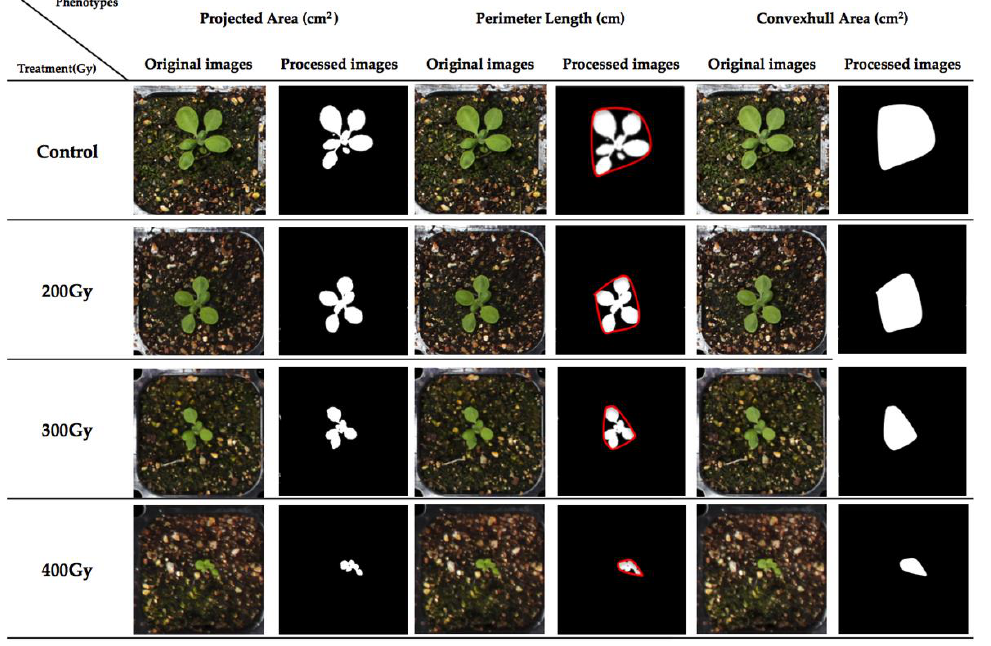
Figure 1. Definition of digital phenotypes and comparison among different gamma radiation doses at 17 days after sowing.